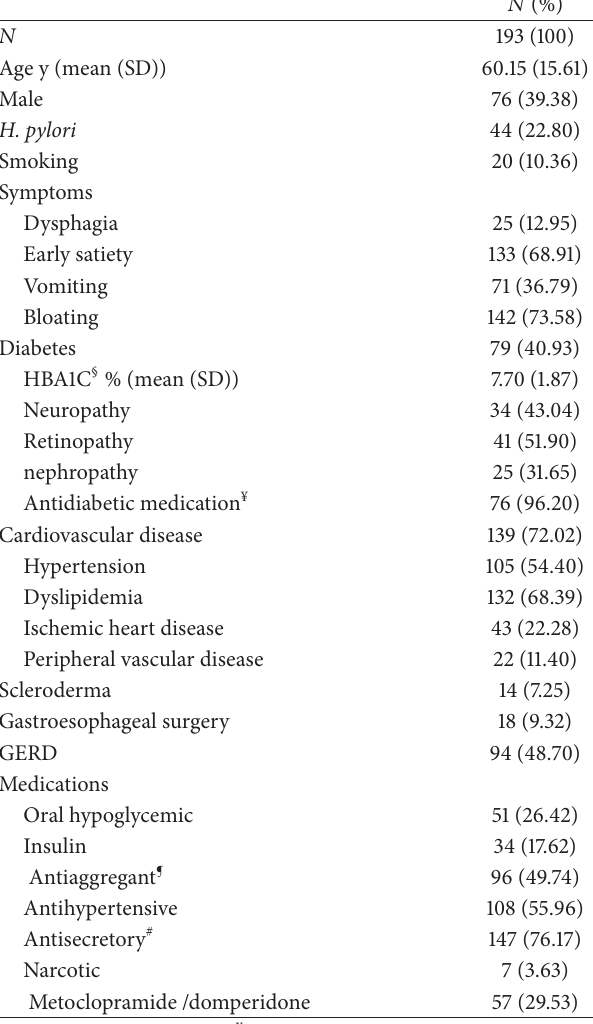
Table 1: Patient